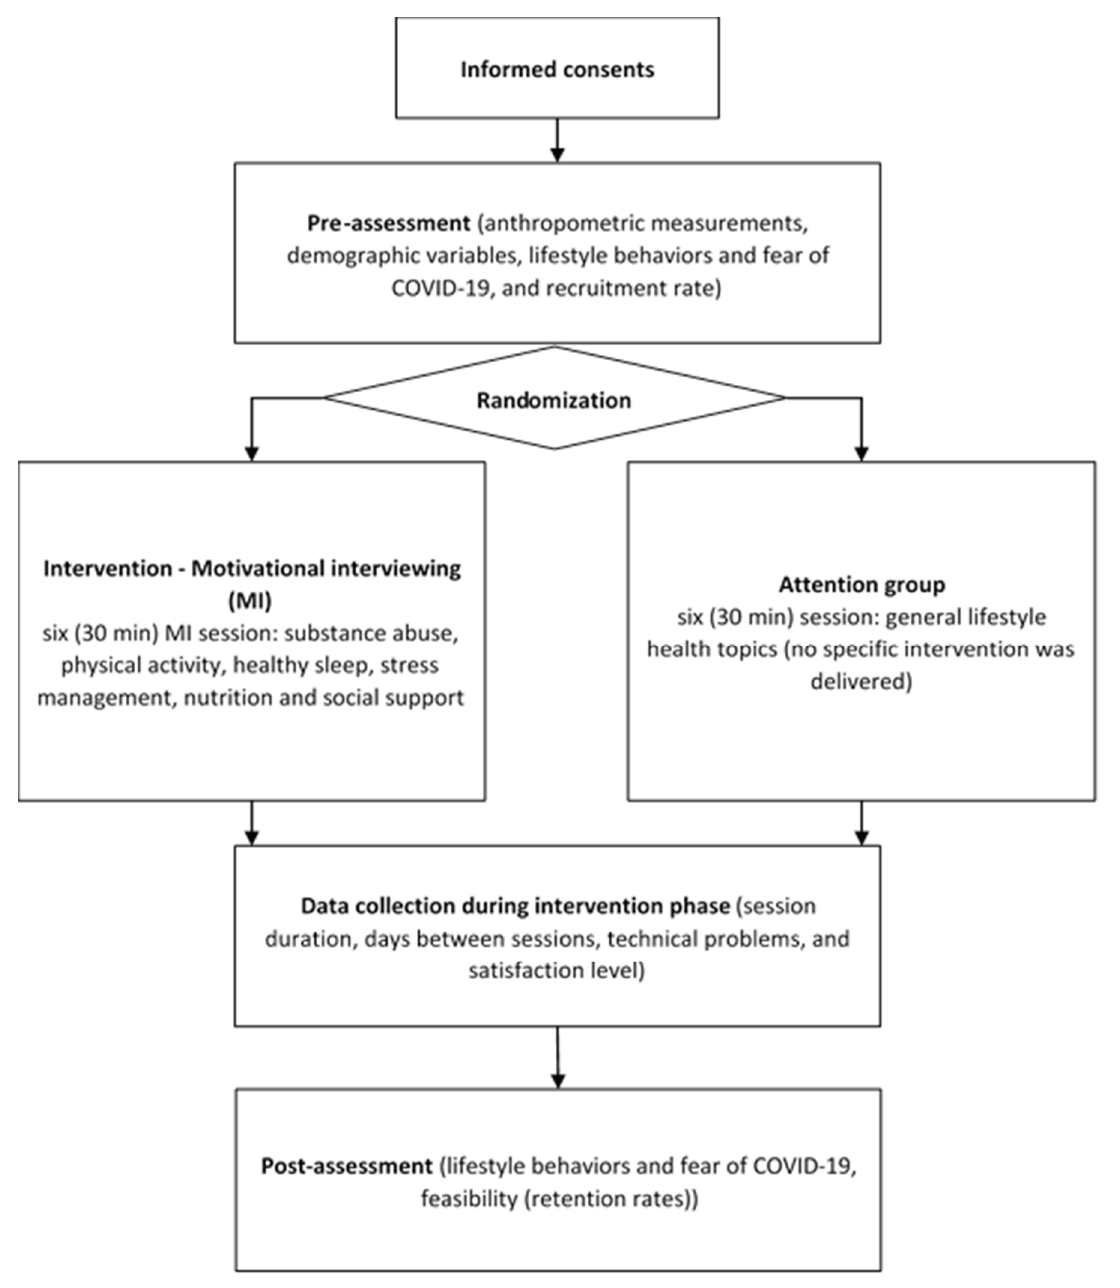
Figure 1. Overview of the study design.